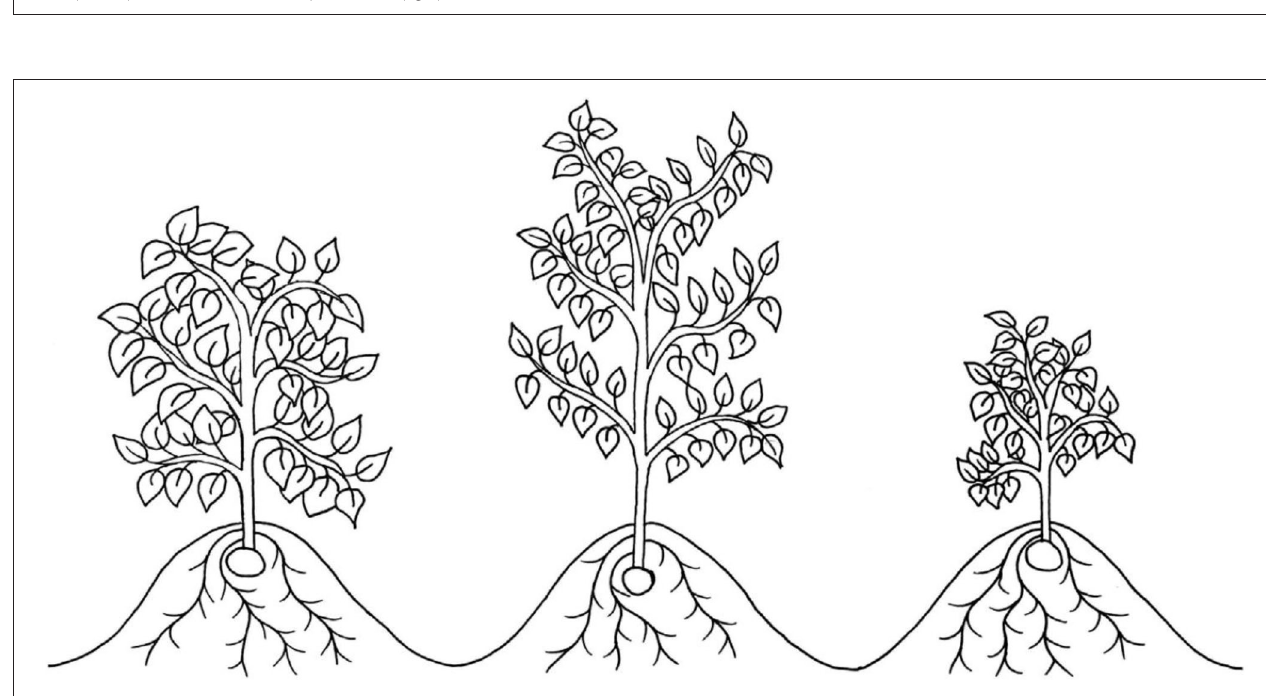
FIGURE 2 | An illustration of three canopy architectures, two of which have been suggested to improve drought tolerance in potato: open “stem-type” canopies, e.g., cv. Tomba, which may improve light penetrance and interception (middle), and very small canopies, e.g., cv. Alpha, which may reduce evapotranspirative water loss (right). A dense “leaf-type” canopy, e.g., cv. Procudent, which has been suggested to be detrimental to potato yields under drought is also illustrated (left).